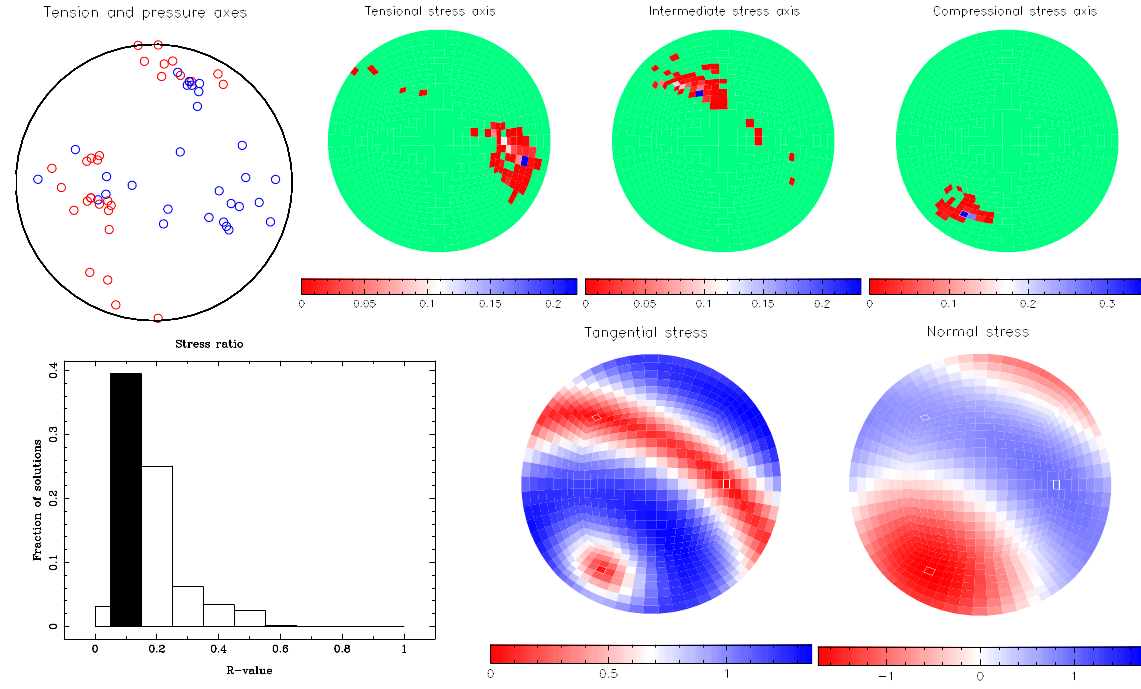
Fig. 10. Results of stress inversion for cluster of shallow earthquakes near Zante. Explanation of subfigures is as in Fig. 5.